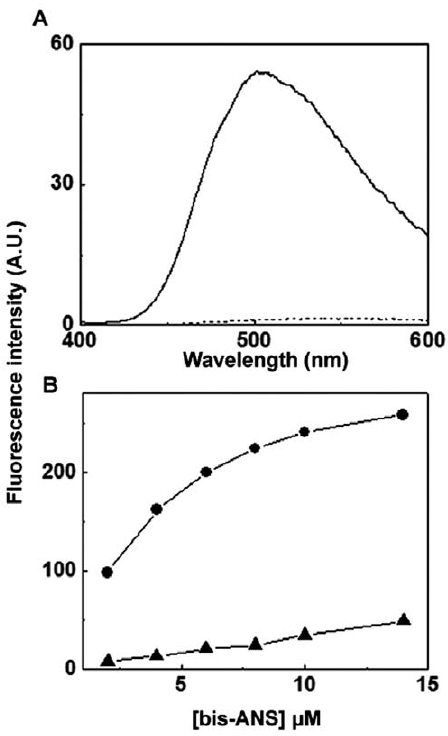
Figure 5. Bis-ANS binding to HspB2. (a) Fluorescence spectra of bis-ANS alone (dotted line) and bis-ANS bound to human HspB2 (solid line). Bis-ANS was added to the final concentration of 10 m M and the spectra were recorded using an excitation wavelength of 390 nm with the excitation and emission band passes set at 2.5 nm. (b) Bis-ANS titration of human HspB2. Bis-ANS fluorescence was measured as N described above after sequential additions of bis-ANS to the protein -) a B-crystallin, (- m -) solutions. (-